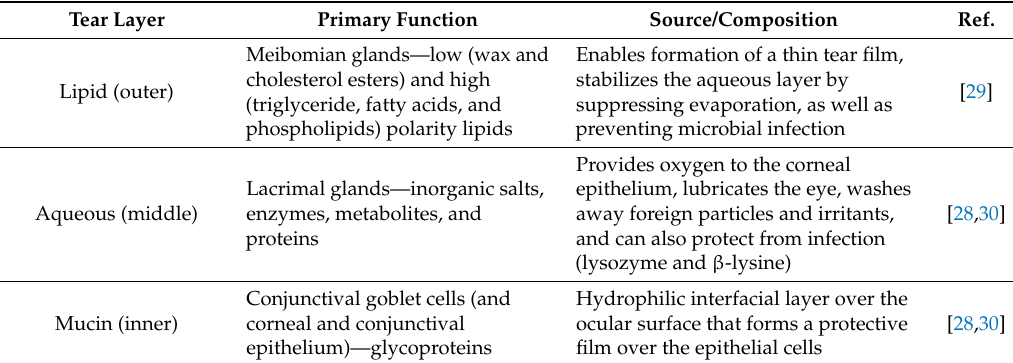
Table 1. Tear film compositions and